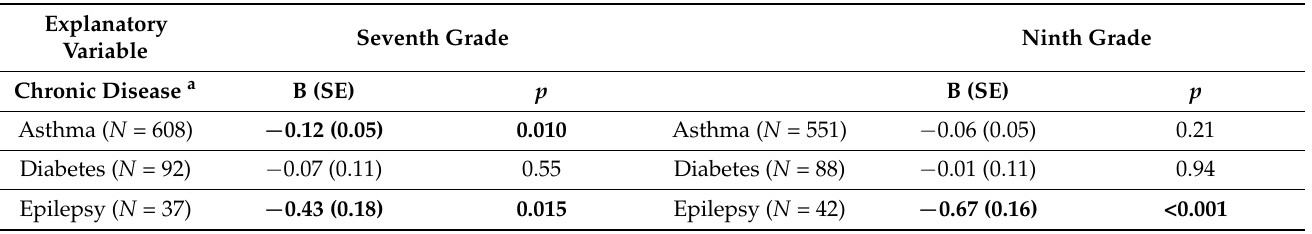
Table A1. The associations between individual chronic diseases and the grade point average (GPA) in the seventh and ninth grade, adjusting for gender. Linear regression analyses.